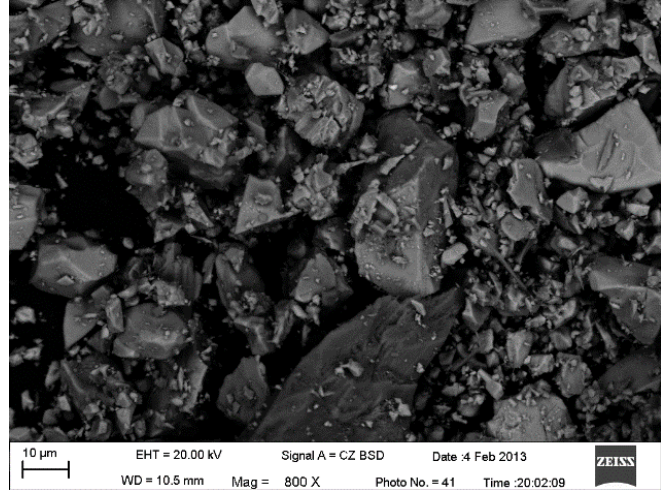
Figure 2. Particle size distribution of the iron concentrate.